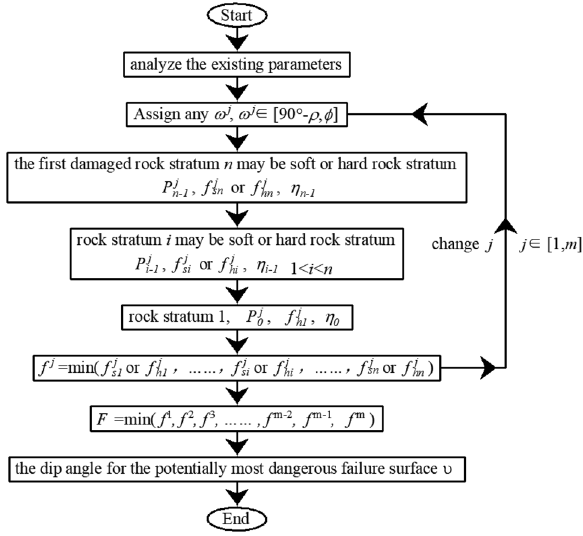
Figure 9. The flow of the calculation for the dip angle of the potentially most dangerous failure